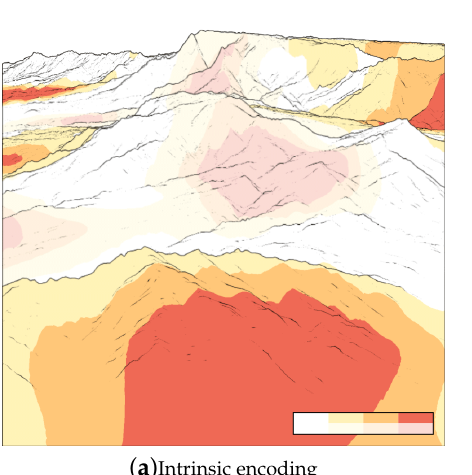
Figure 3. Strategies for data. ( a ) Aggregation via a segmented color scale shows basic qualitative characteristics of the data; ( b ) More detail can be discerned when individual data values are visualized using a continuous color scale.